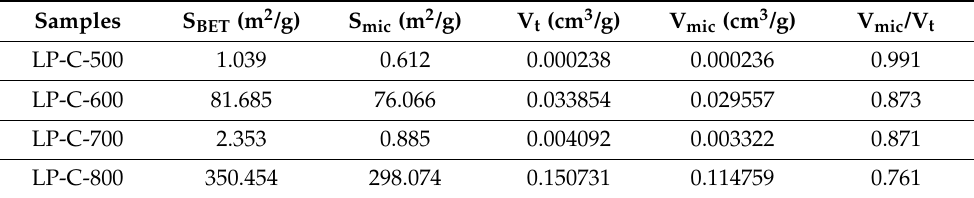
Table 1. Pore structure parameters from N 2 adsorption of